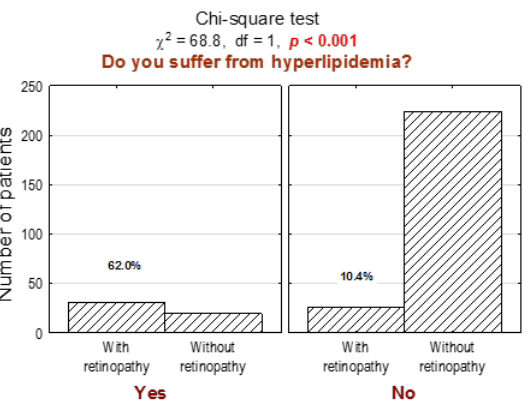
Figure 7. Number ( n ) and percentage (%) of patients in groups differing in the presence of diabetic retinopathy and hyperlipidemia, and the test of independence.